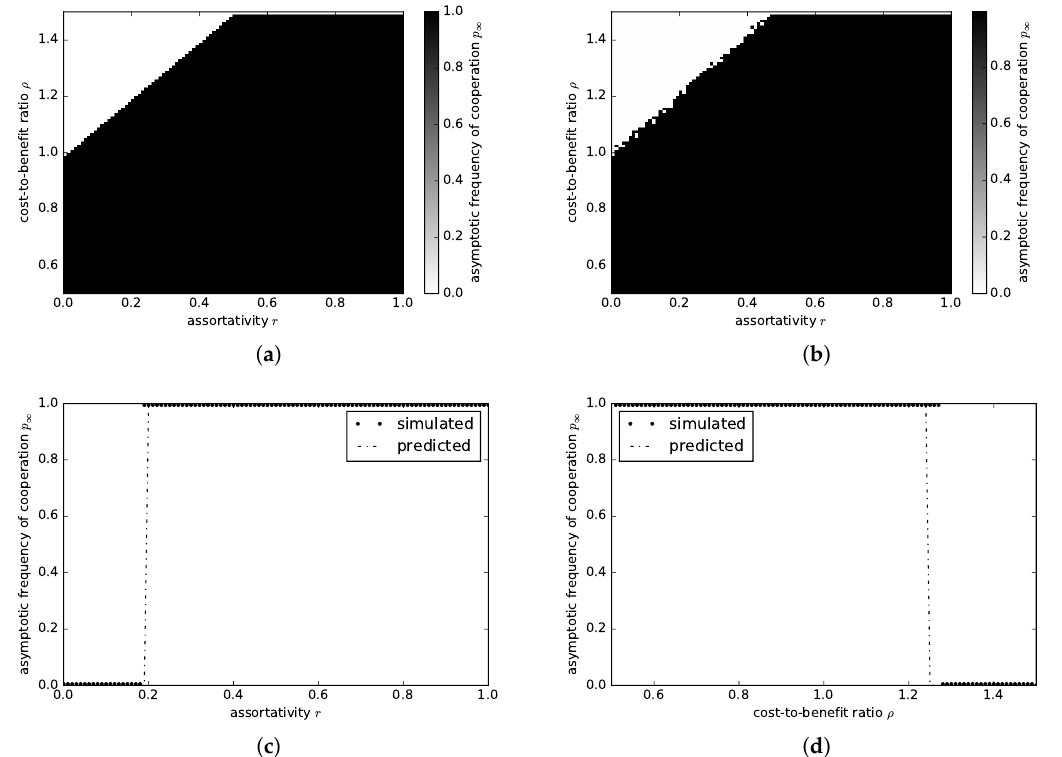
Figure 6. Variation of the long-term frequency p ∞ of cooperators with assortativity r ∈ [ 0,1 ] and ) for the sculling game. ( a ) p ∞ (analytically predicted) versus r and ρ . cost-to-benefit ratio ρ ∈ ( 1 , 3 2 2 ( b ) p ∞ (simulated) versus r and ρ . ( c ) p ∞ versus r when ρ = 1.2. ( d ) p ∞ versus ρ when r = 0.25. Parameters: n = 10,000, p 0 = 0.5, and β =